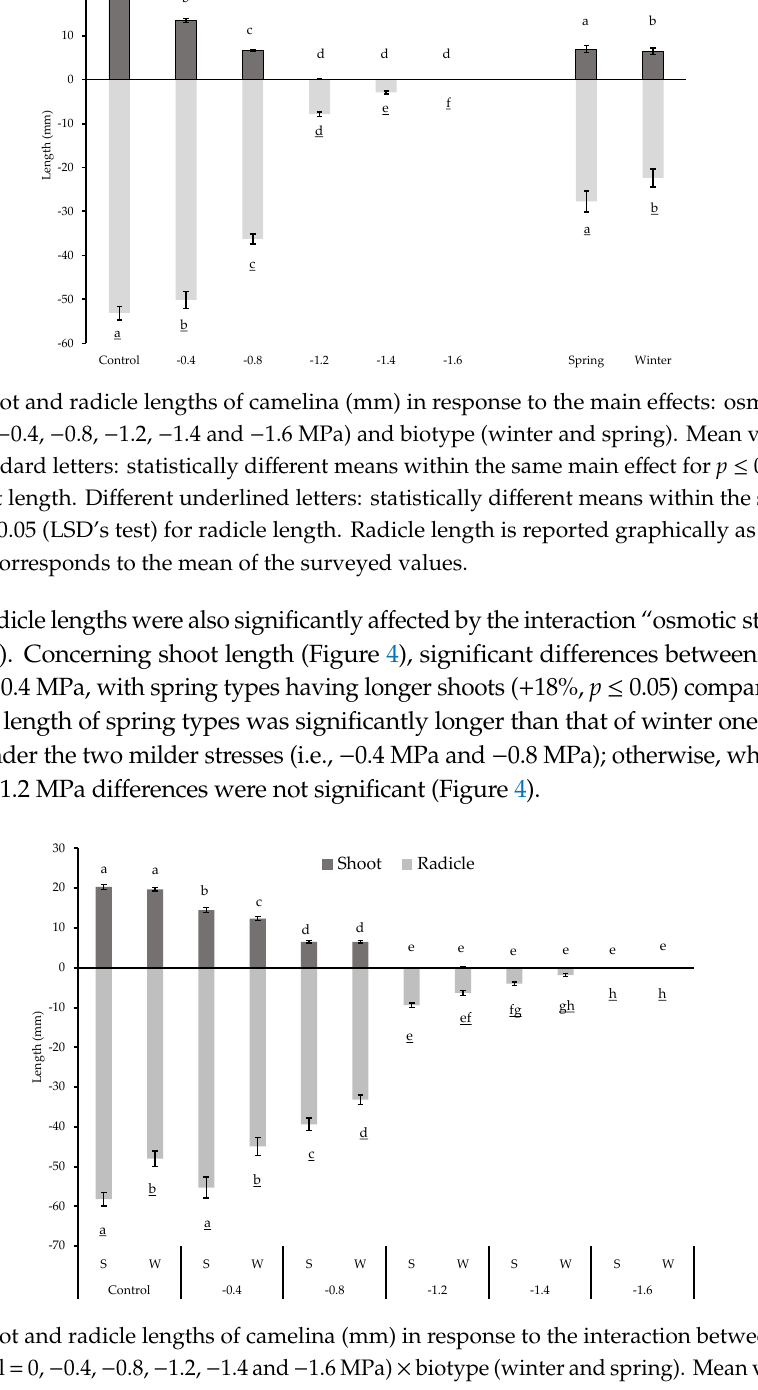
Figure 4. Shoot and radicle lengths of camelina (mm) in response to the interaction between osmotic stress (Control = 0, −0.4, −0.8, −1.2, −1.4 and −1.6 MPa) × biotype (winter and spring). Mean values ± SE. Different standard letters: statistically different means within the same main effect for p ≤ 0.05 (LSD’s test) for shoot length. Different underlined letters: statistically different means within the same main effect for P ≤ 0.05 (LSD’s test) for radicle length. Radicle length is reported graphically as a negative value, but it corresponds to the mean of the surveyed values.